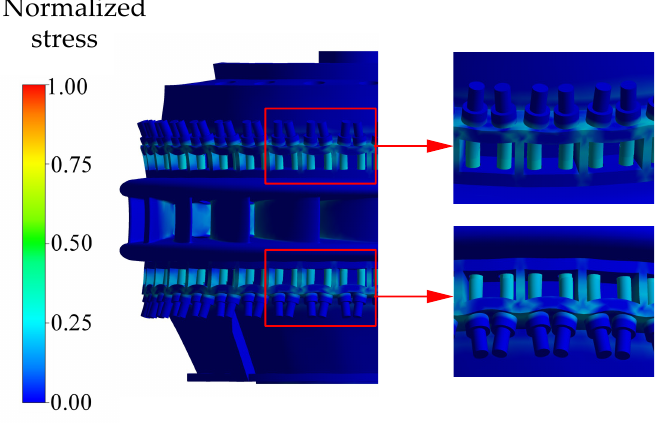
Figure 18. The stress distribution of the large stationary structures and the connection bolts. The stress distributions of the head-cover bolts and the bottom ring bolts during the process of turbine load rejection are demonstrated in Figure 19. The analysis shows that the stress distribution of the connection bolts is similar in general. The maximum stress of the head-cover bolt is located at the bolt fillet close to the head-cover bolt flange, while the maximum stress of the bottom ring bolt is concentrated at the bolt fillet near the bottom ring bolt